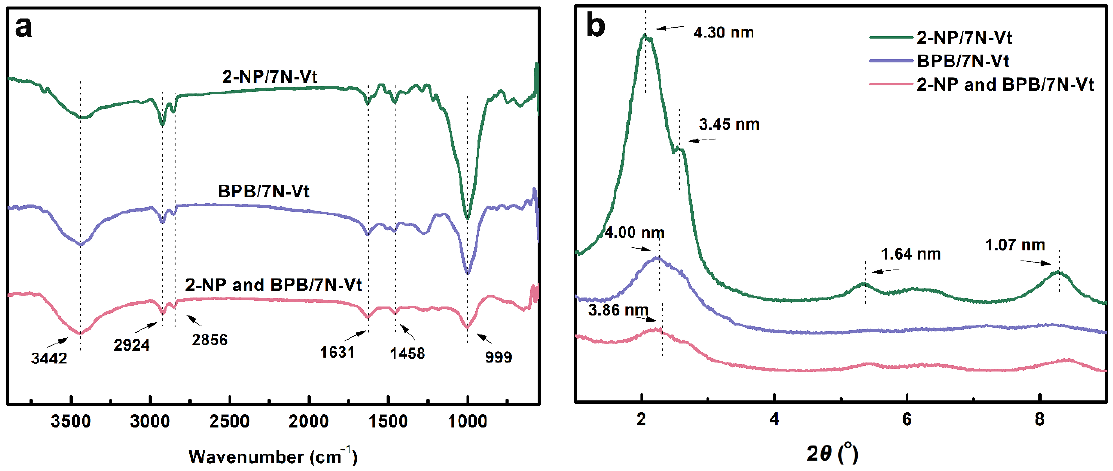
Figure 9. The FT-IR spectra ( a ) and XRD patterns ( b ) of adsorbed organo-Vts.